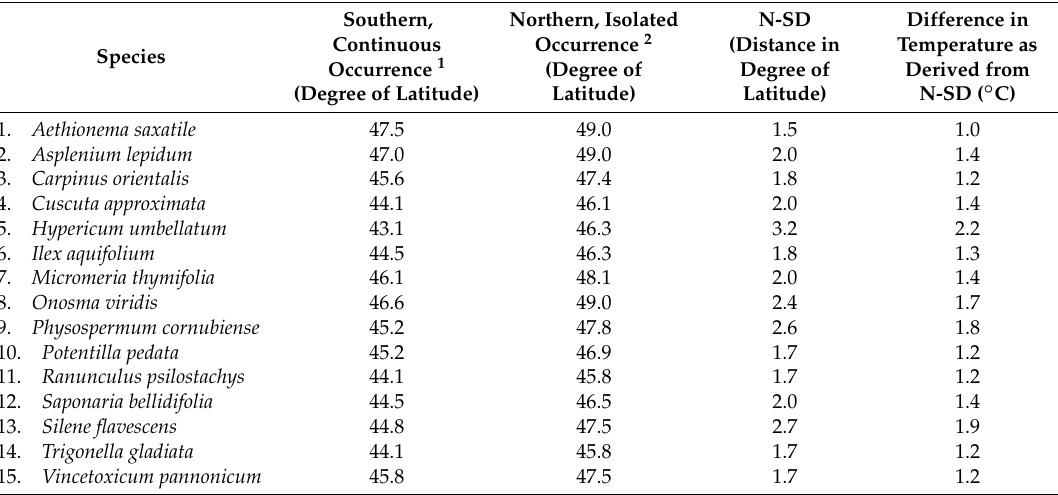
Table 1. Final list of the selected 15 species.